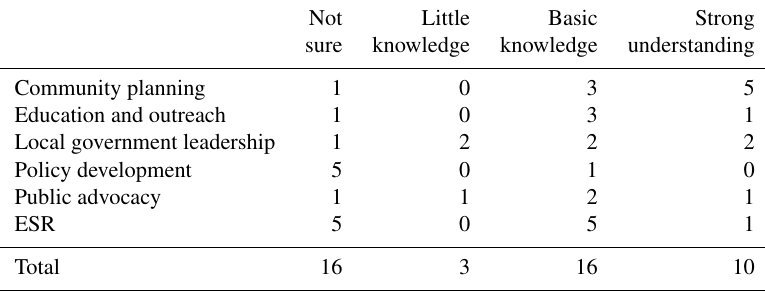
Table 5. Perceptions of general community knowledge level of climate science and adaptation. Not Little Basic Strong sure knowledge knowledge understanding Community